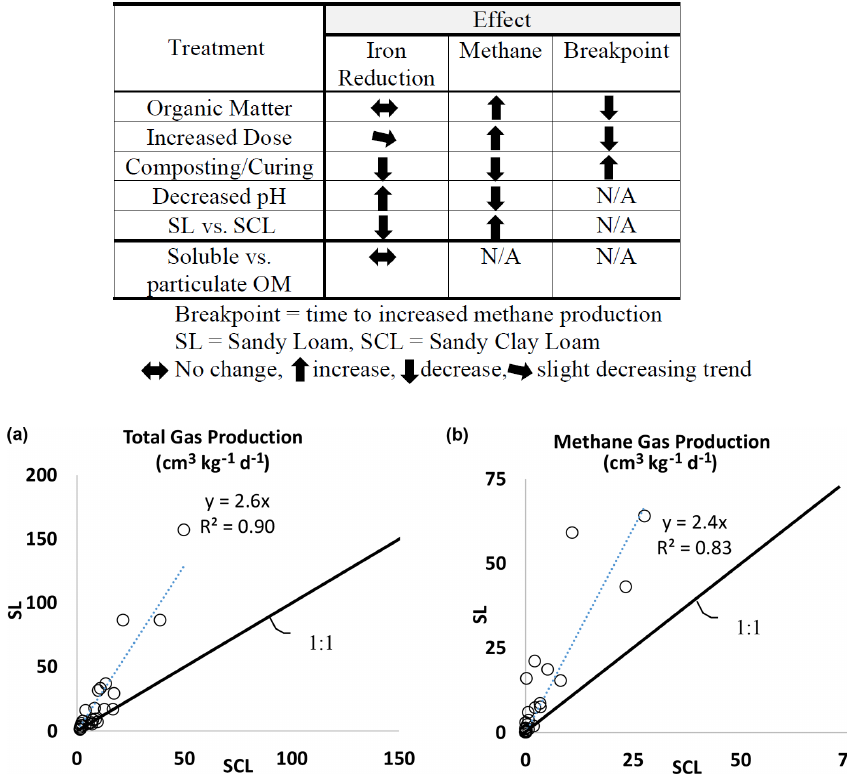
Figure 2. (a) Experiment 1. Total biogenic gas production rate in the SL soil versus the SCL mesocosms. The SL mesocosms had, on average, 2.6 times higher gas production than SCL. (b) Experiment 1. Biogenic methane gas production rate in the SL soil versus the